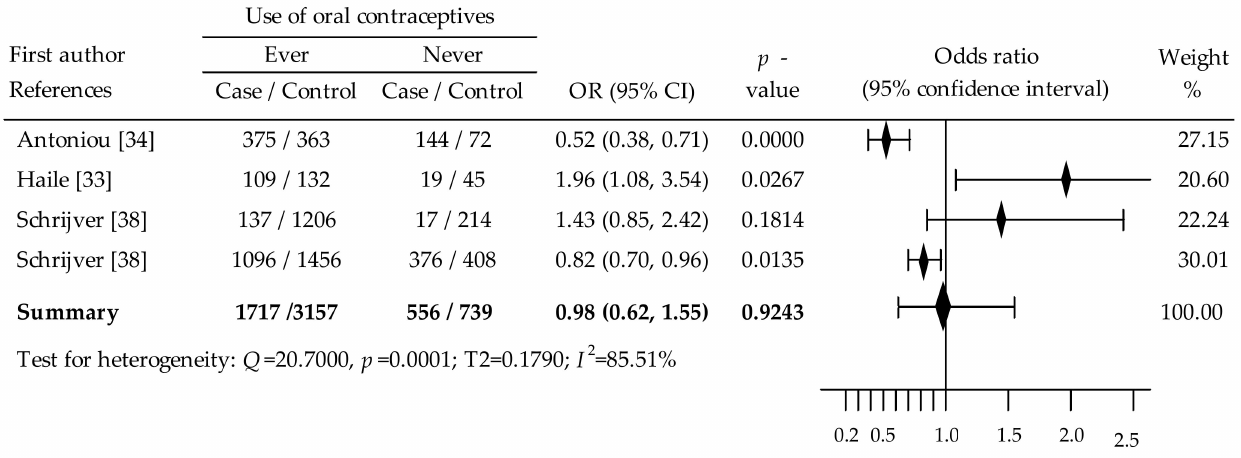
Figure 4. Forest plots for association between oral contraceptives and breast cancer in BRCA2 mutation carriers [33,34,38]. Note: data are expressed as mean differences with 95% CIs, using random effects models; effect is represented by the block diamond; the horizontal lines denote the 95%